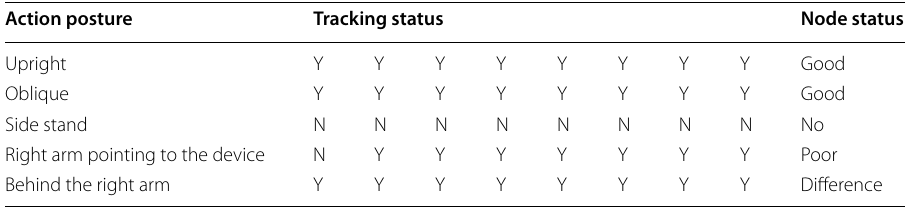
Table 4 Tracking status and node status of different postures